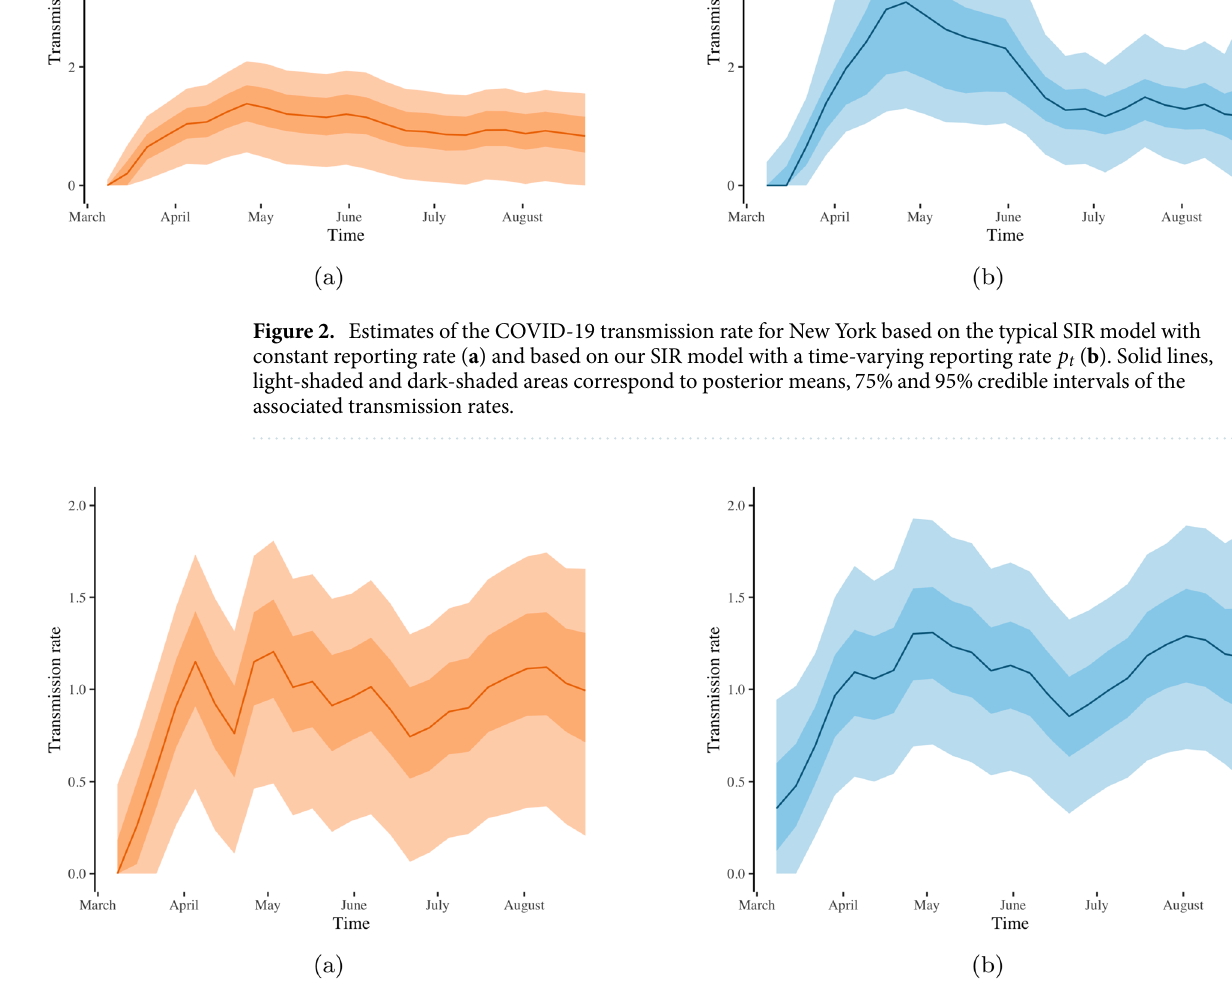
Figure 3. Estimates of the COVID-19 transmission rate for Tennessee based on the typical SIR model with constant reporting rate ( a ) and based on our SIR model with a time-varying reporting rate p t ( b ). Solid lines, light-shaded and dark-shaded areas correspond to posterior means, 75% and 95% credible intervals of the associated transmission